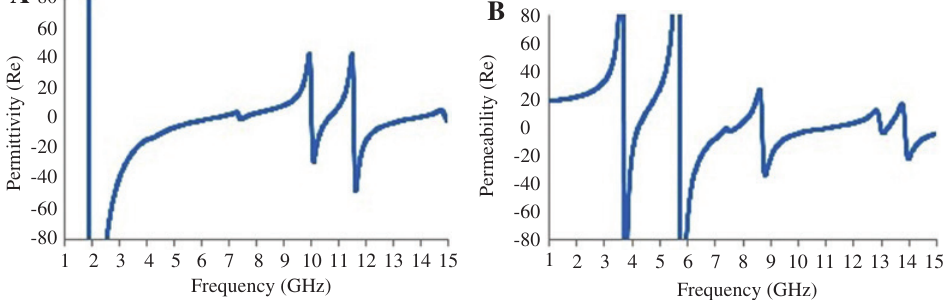
Figure 6: (A) Real value of effective permittivity versus frequency and (B) real value of effective permeability versus frequency for the x -axis wave